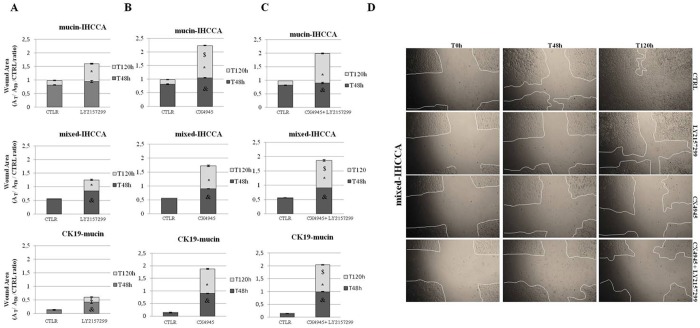
Wounding-healing assays.Mucin-IHCCA, mixed-IHCCA and CK19-mucin cell cultures were treated with LY2157299 (50 μM), CX4945 (10μM) or LY2157299 (50 μM) + CX4945 (10μM). A: pharmacological inhibition of TGF-ΒR1 by LY2157299 produced inhibitory effects on cell migration. In mucin-IHCCA the effects of LY2157299 were evident at 120 hrs, while in mixed-IHCCA and CK19-mucin effects were already visible at 48hrs. & = p<0.05 vs CTLR;* = p<0.05 vs CTLR. B: CX4945 exerted more evident inhibitory effects on cell migration in mucin-IHCCA and the effects were higher with respect to LY2157299. & = p<0.05 vs CTLR and LY2157299 alone; * = p<0.05 vs CTLR and LY2157299 alone; $ = p< 0.05 vs mixed- and CK19-mucin. C: the combination of CX4945 andLY2157299 exerted relatively more evident additive effects on cell migration in mixed-IHCCA than in CK19-mucin, but no additive effect was seen in mucin-IHCCA. & = p<0.05 vs CTLR;* = p<0.05 vs CTLR; $ = p< 0.05 vs CX4945 alone. D: representative images of mixed-IHCCA cell cultures where the synergistic effect of CX4945+LY2157299 was more evident with respect to the other cell lines. The wound area was calculated with respect to control at T0, considered as 1. Mean +/- SD of N = 3–5 independent experiments.